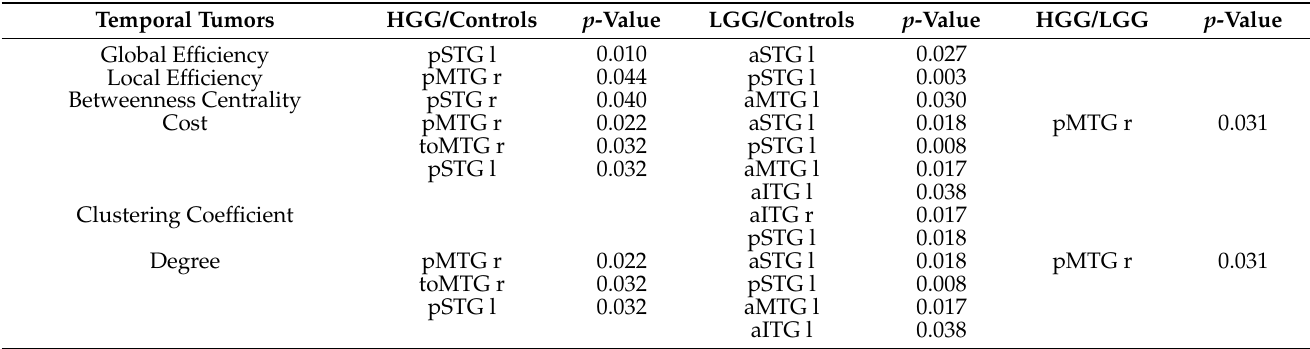
Table 1. Graph-theory statistics results for gliomas involving the frontal lobe. Significance is re- ported as FDR corrected p -value.